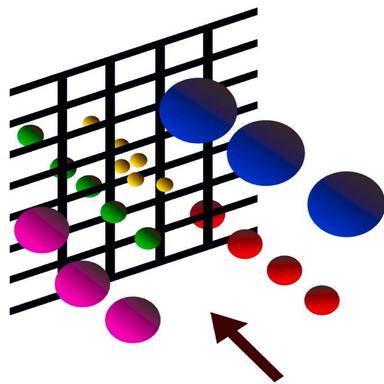
Illustration of the MOF capability to give entrance permission, only, to particles with a specific size.